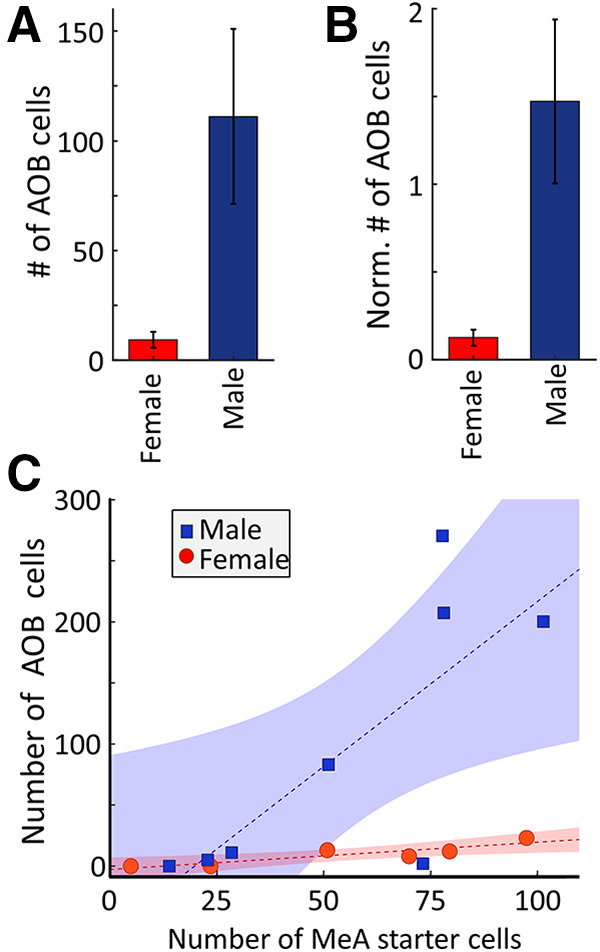
Sex differences in the AOB projection to arom+ MeA neurons. A, The average number of arom+ projecting AOB neurons in female (red) or male (blue) mice. B, Average number of arom+ projecting AOB neurons in female (red) or male (blue) mice after normalization by the number of starter neurons in the MeA. C, Relationship between the numbers of arom+ starter neurons in the MeA and →arom+ neurons in the AOB of male (blue squares) and female (red circles) mice. Dashed lines indicate the best linear fit to the data, and the shaded regions indicate the 95% confidence interval on each fit. Error bars indicate SEM.